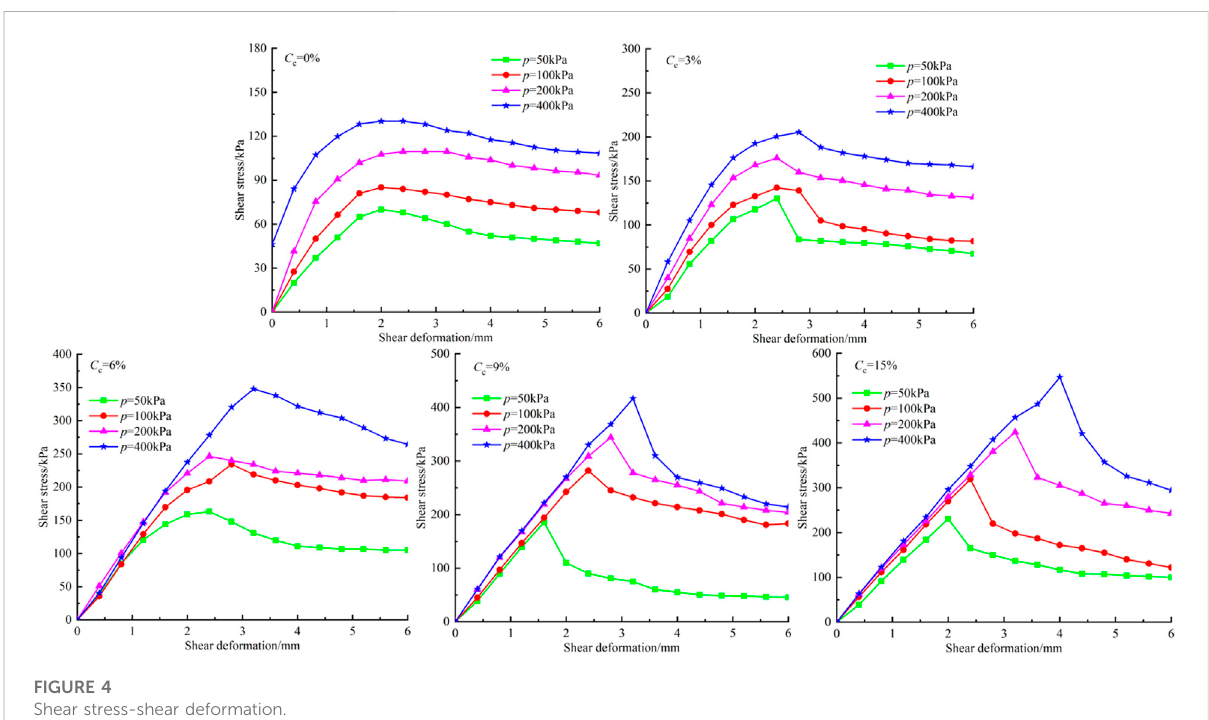
FIGURE 4 Shear stress-shear deformation.